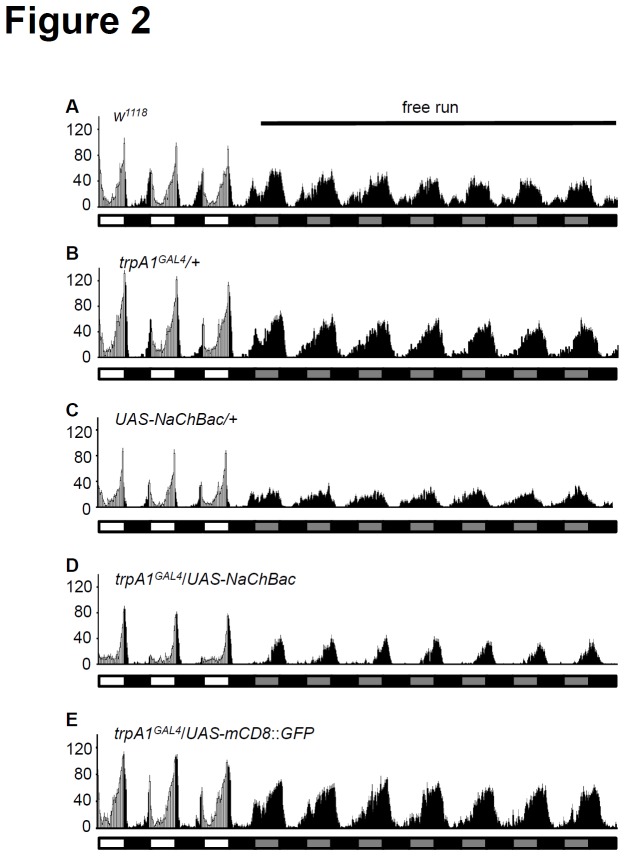
Activation of trpA1 neurons affects morning peak and evening slope.Averaged activity profiles during light/dark (LD3) and free running at constant dark cycles at 18°C are shown in the following genotypes: (A) w
1118, (B) trpA1
GAL4/+, (C) UAS-NaChBac/+, (D) UAS-NaChBac/trpA1
GAL4, and (E) UAS-mCD8::GFP/trpA1
GAL4.